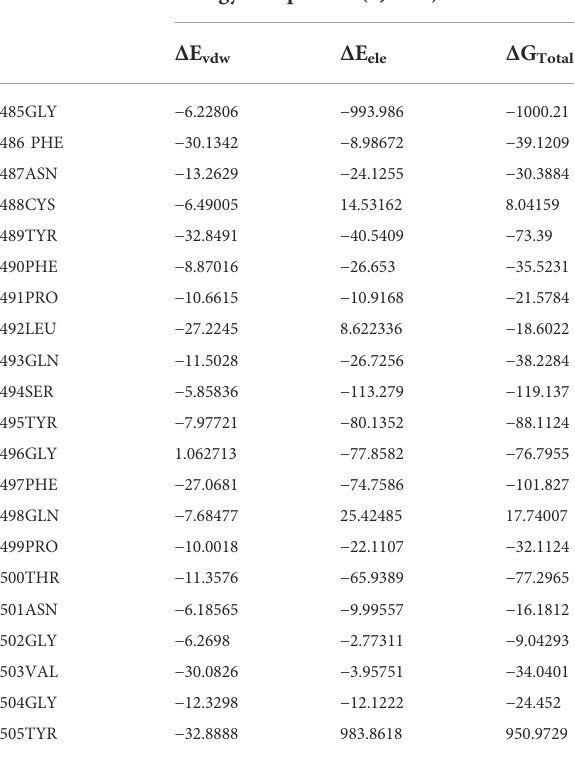
TABLE 1 The mmpbsa energy analysis of the template residues revealed by a 50-ns MD